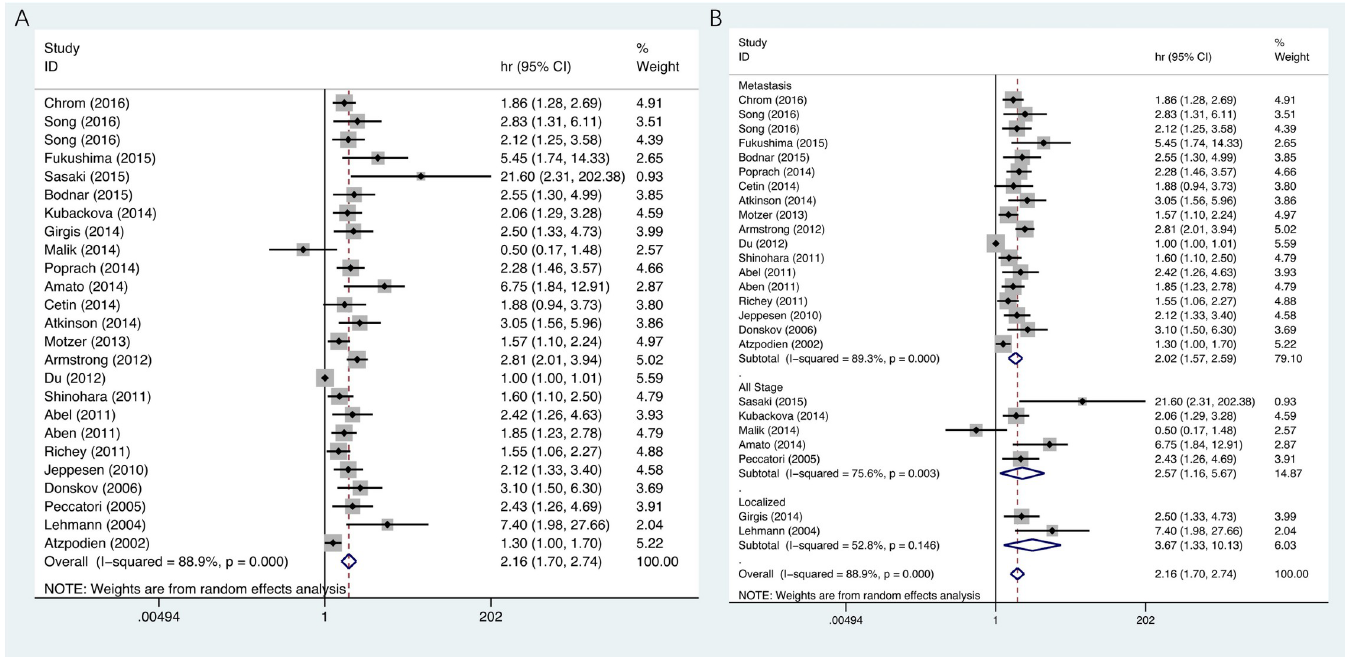
Fig 2. A. Forest plots of studies evaluating hazard ratios of elevated serum LDH level in all renal cell carcinoma (RCC) for overall survival. B. Forest plot of the relationship between elevated serum LDH level and overall survival in patients with different tumor types.